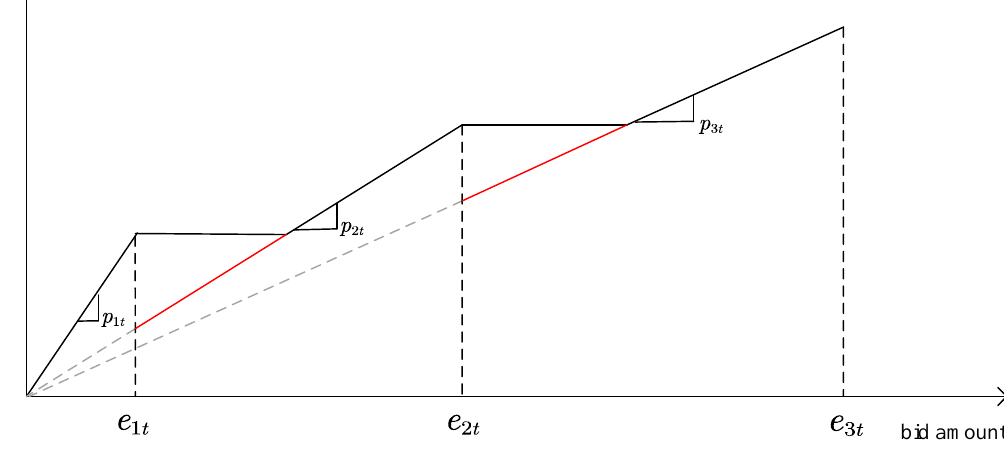
Figure 2. The function diagram of the return of the price taker.